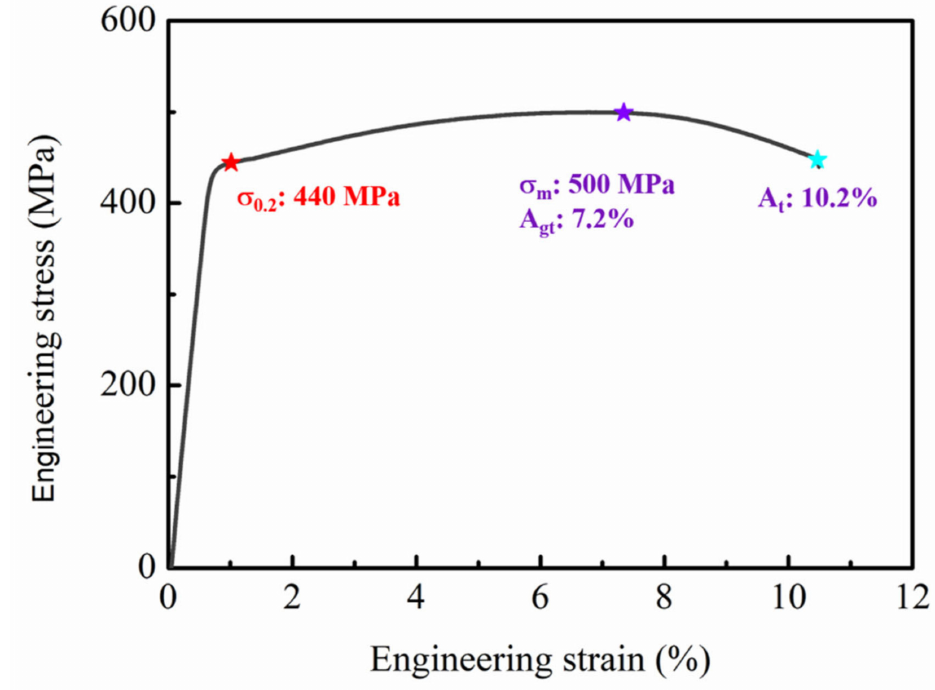
Figure 4. Tensile stress–strain curve of the overaged Al-Zn-Mg-Cu